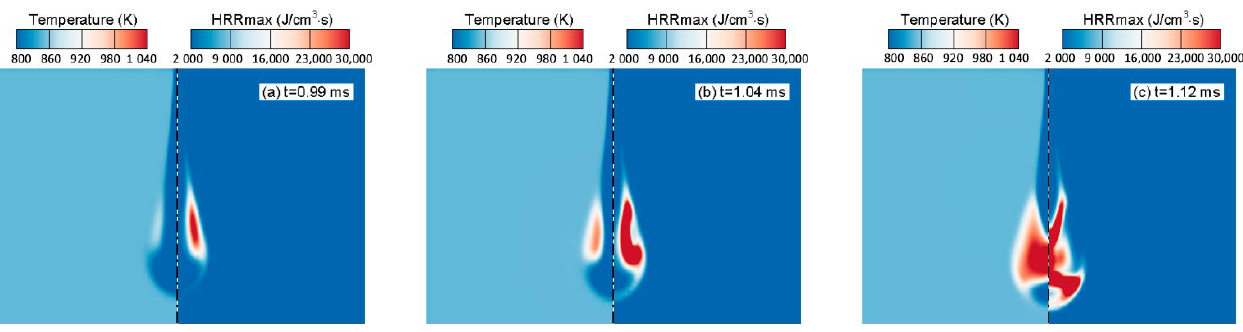
Figure 8. Temperature and HRR distribution of n-heptane in CVB at an initial temperature of 850 K, ambient oxygen concentration of 21%, gas density of 14.8 kg/m 3 , and a hole diameter of 0.15 mm.